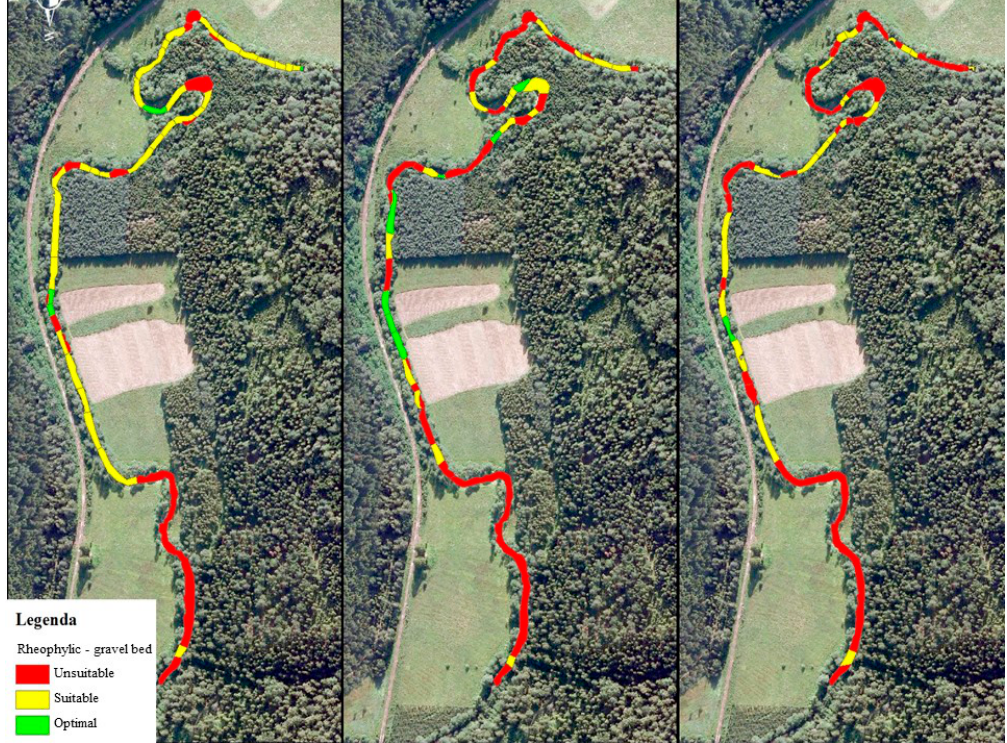
Figure 6. Maps of suitable habitat areas for the Skawa River (lskm stands for L·s − 1 ·km − 2 ).